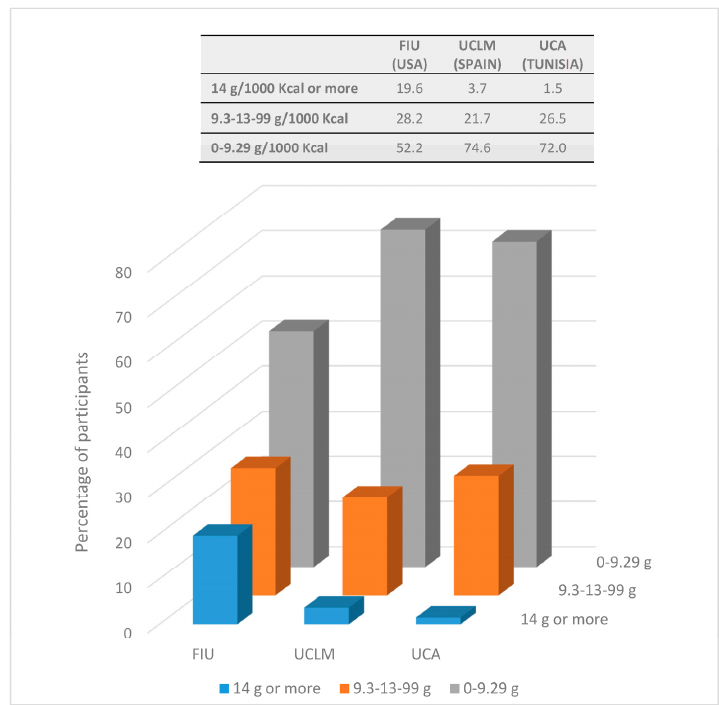
Figure 1. Percentage of participants consuming less than two thirds of the AI, those who consumed between two thirds of the AI and the AI, and those consuming at least the AI (14 g/1000 Kcal). AI: Adequate Intake; FIU: Florida International University; UCLM: University of Castilla-La Mancha; UCA: University of